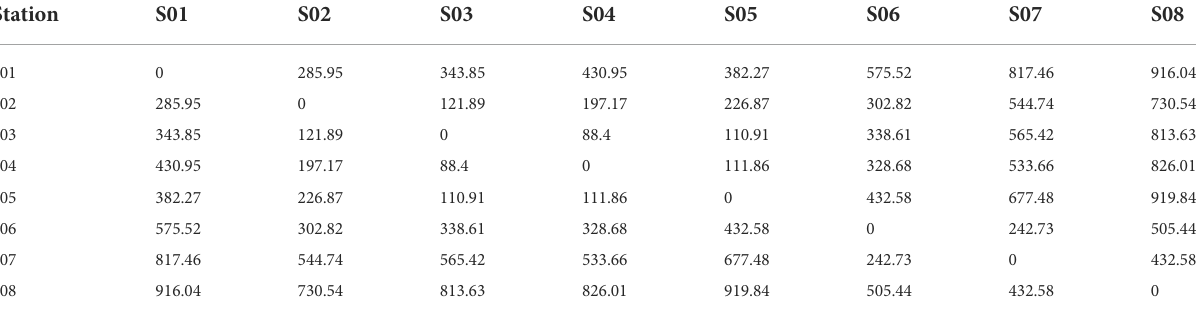
TABLE 1 Separation distance of station-to-station (unit: m). Station